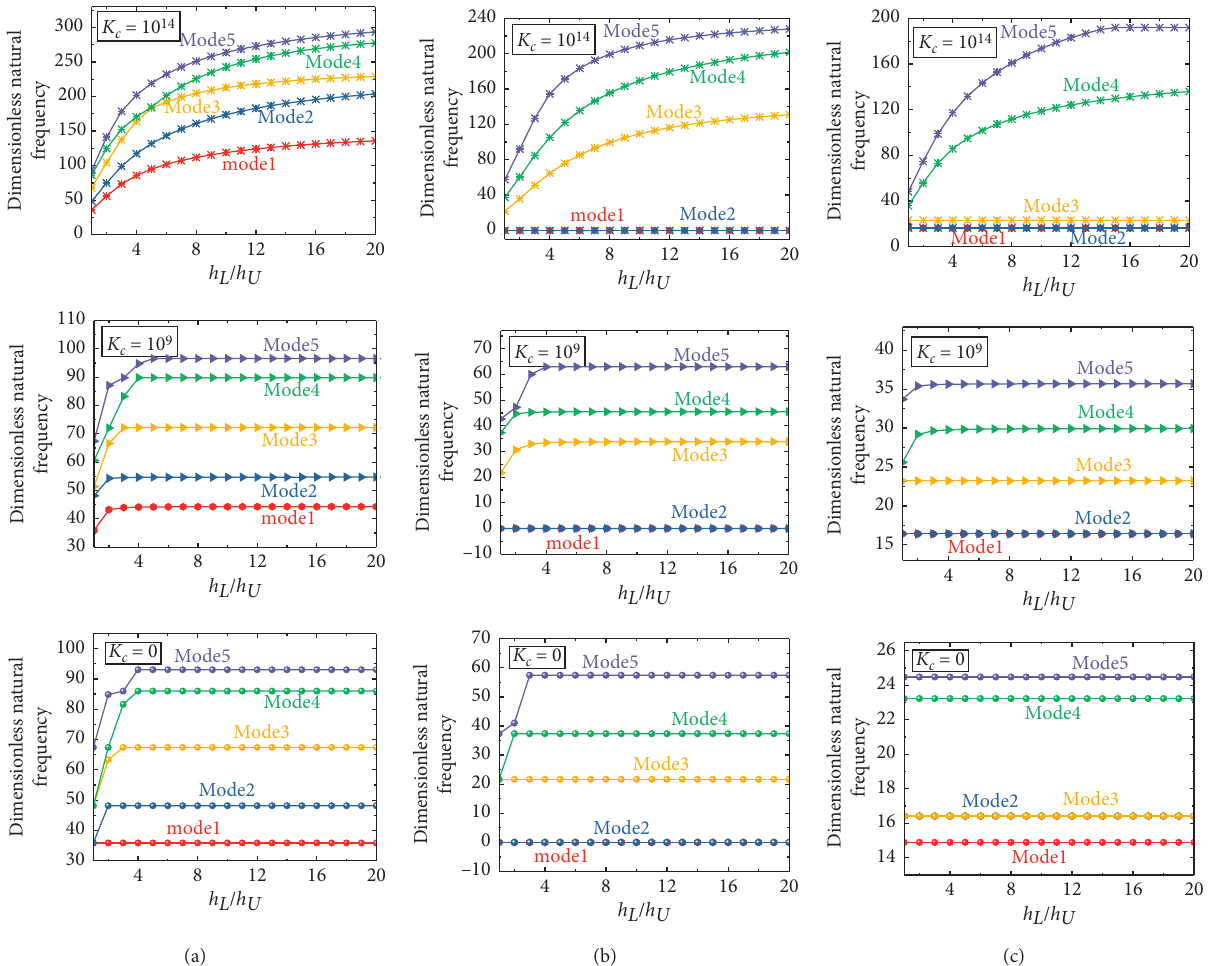
Figure 8: Variation of dimensionless natural frequency versus thickness for an LCDPS with different conditions. (a) CCCC-CCCC; (b) SDSDSDSD-SDSDSDSD; (c) E 1 E 1 E 1 E 1